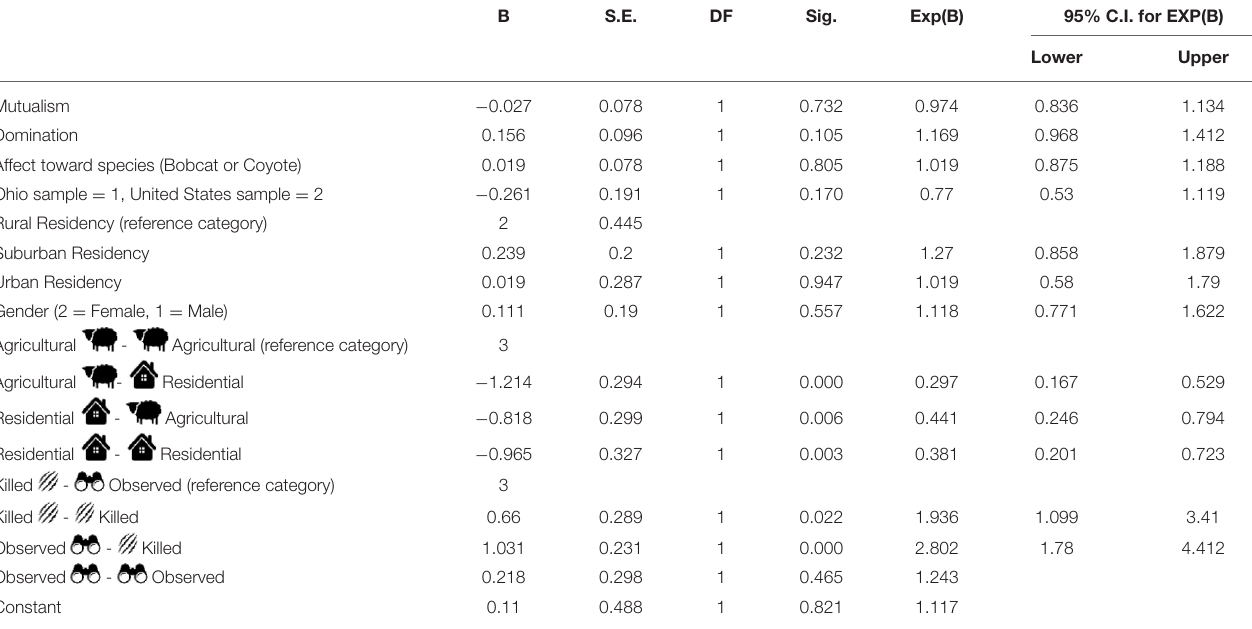
Table 3B | Binary logistic regression predicting the probability of contextual sensitivity or insensitivity using cognitive, demographic, and scenario context combinations as predictors.